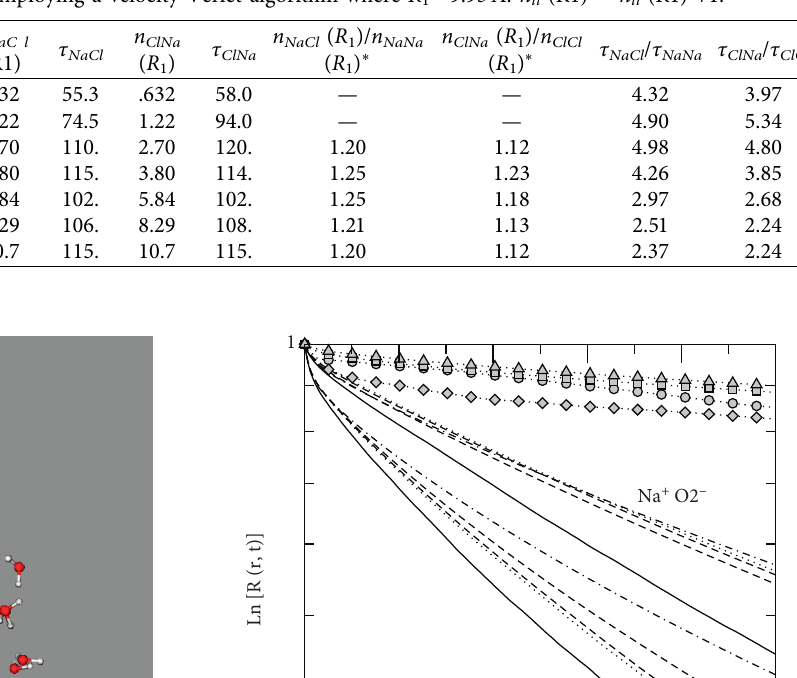
Table 5: Average coordination numbers ( n + and Cl − in the first coordination shells around Na + and ii ( R 1 )) and residence times ( τ ii , ps) of Na